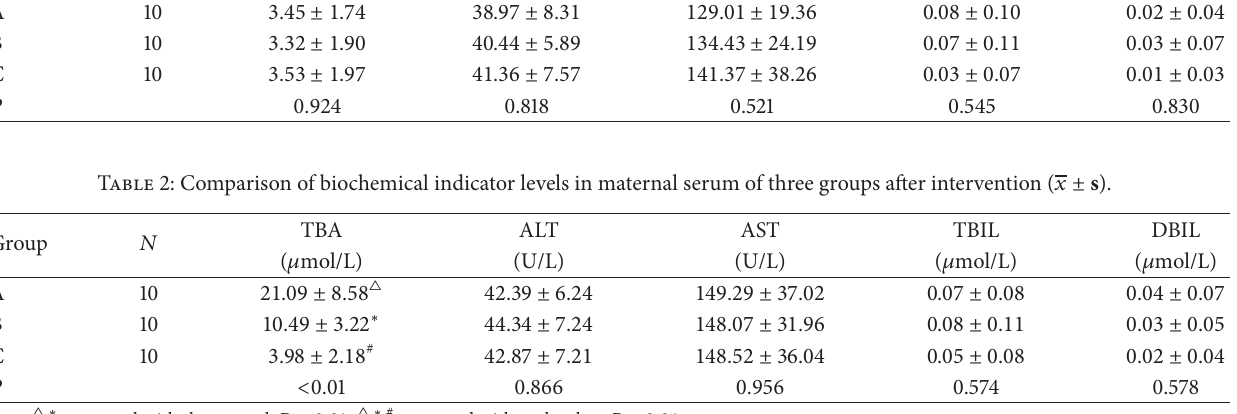
Table 1: Comparison of biochemical indicator level in maternal serum of three groups before intervention ( 𝑥 ± s ). Group